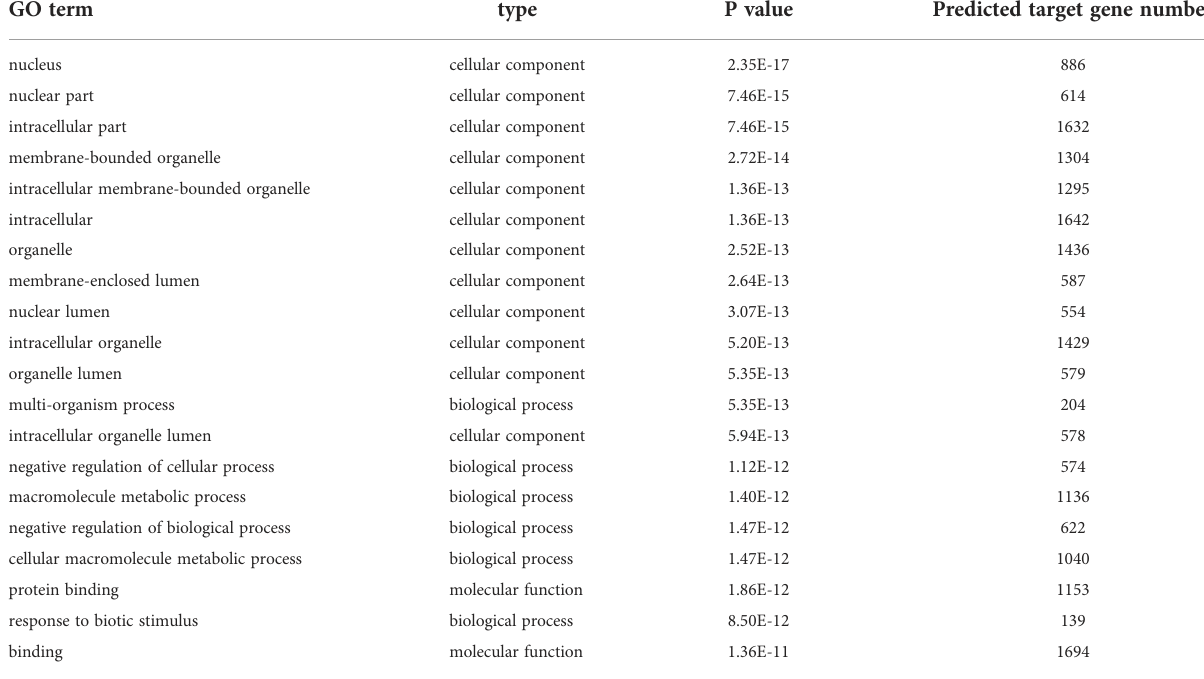
TABLE 3 Top 20 signi fi cantly enriched GO